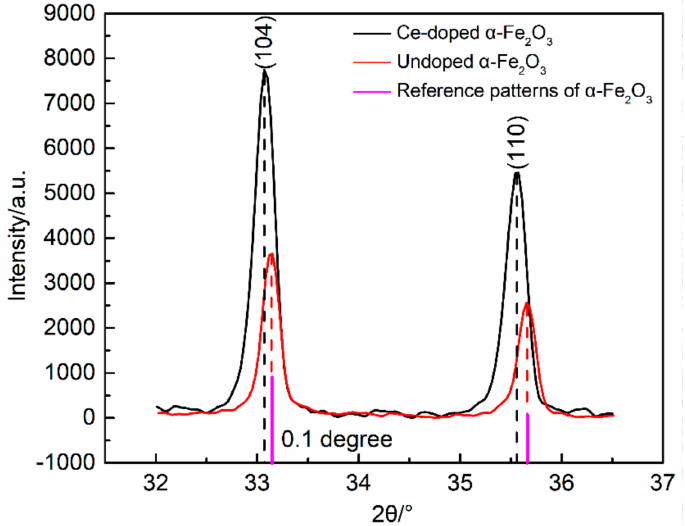
Figure 1. XRD (X-ray di ff raction) pattern of the samples. ( a ) Ce-doped α -Fe 2 O 3 sample; ( b ) undoped α -Fe α -Fe 2 O 3 sample; ( c ) Bayer 2 O 3 sample.